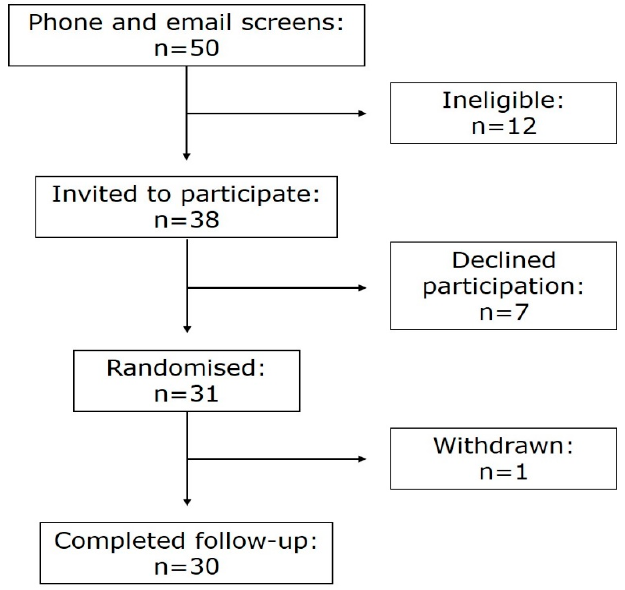
Figure 1. Participant eligibility, enrolment and randomisation.